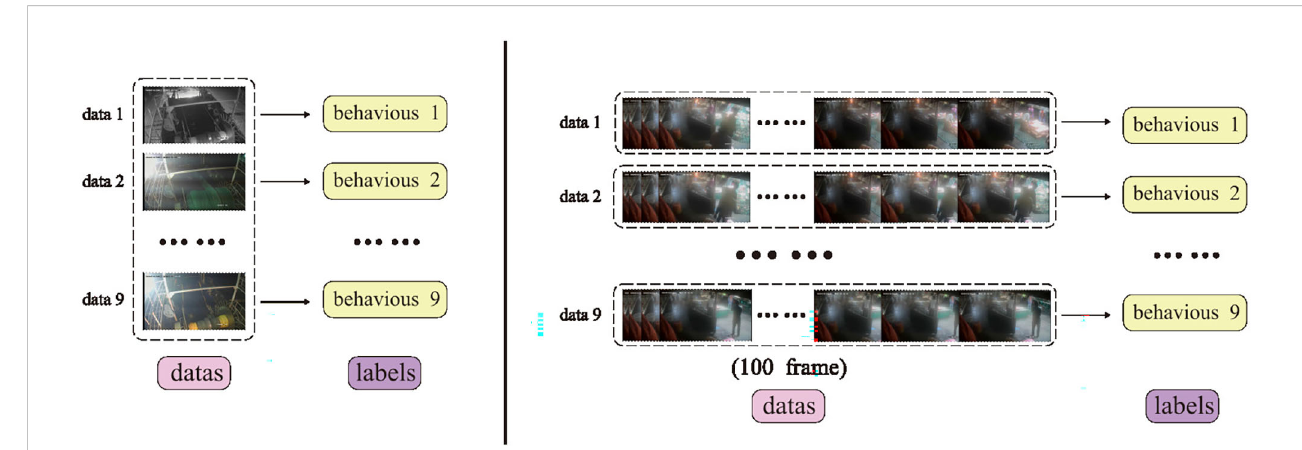
FIGURE 3 The structure of two types of datasets of single-frame samples and multi-frame